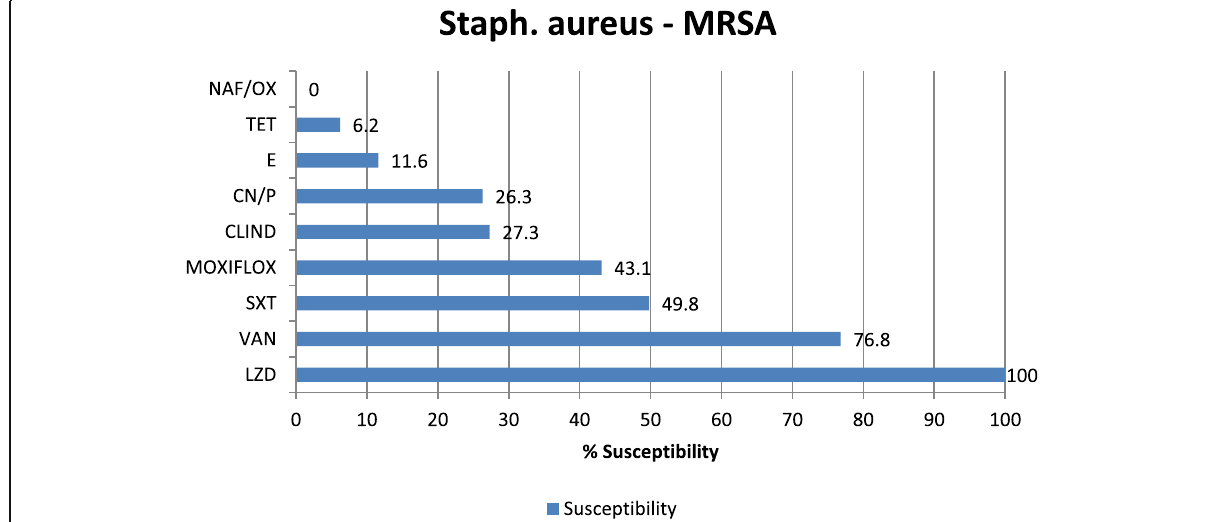
Fig. 7 Antibiotic susceptibility of methicillin-resistant Staph. aureus . MRSA methicillin-resistant Staph. aureus , NAF/OX nafcillin/oxacillin, E erythromycin, CLINDA clindamycin, SXT sulfa-trimethoprim, TET tetracycline, GEN/pen gentamycin/penicillin, MOXIFLOX moxifloxacillin, VAN vancomycin, LZD linezolid